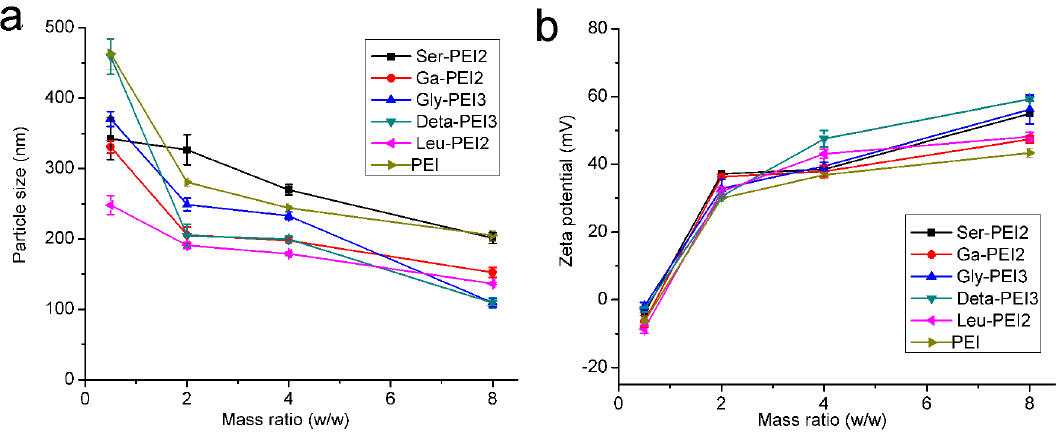
Figure 3. Particle size ( a ) and zeta potential ( b ) of polyplexes obtained from different modified PEIs by dynamic light scattering (DLS). Data represent mean ± SD ( n = 3).